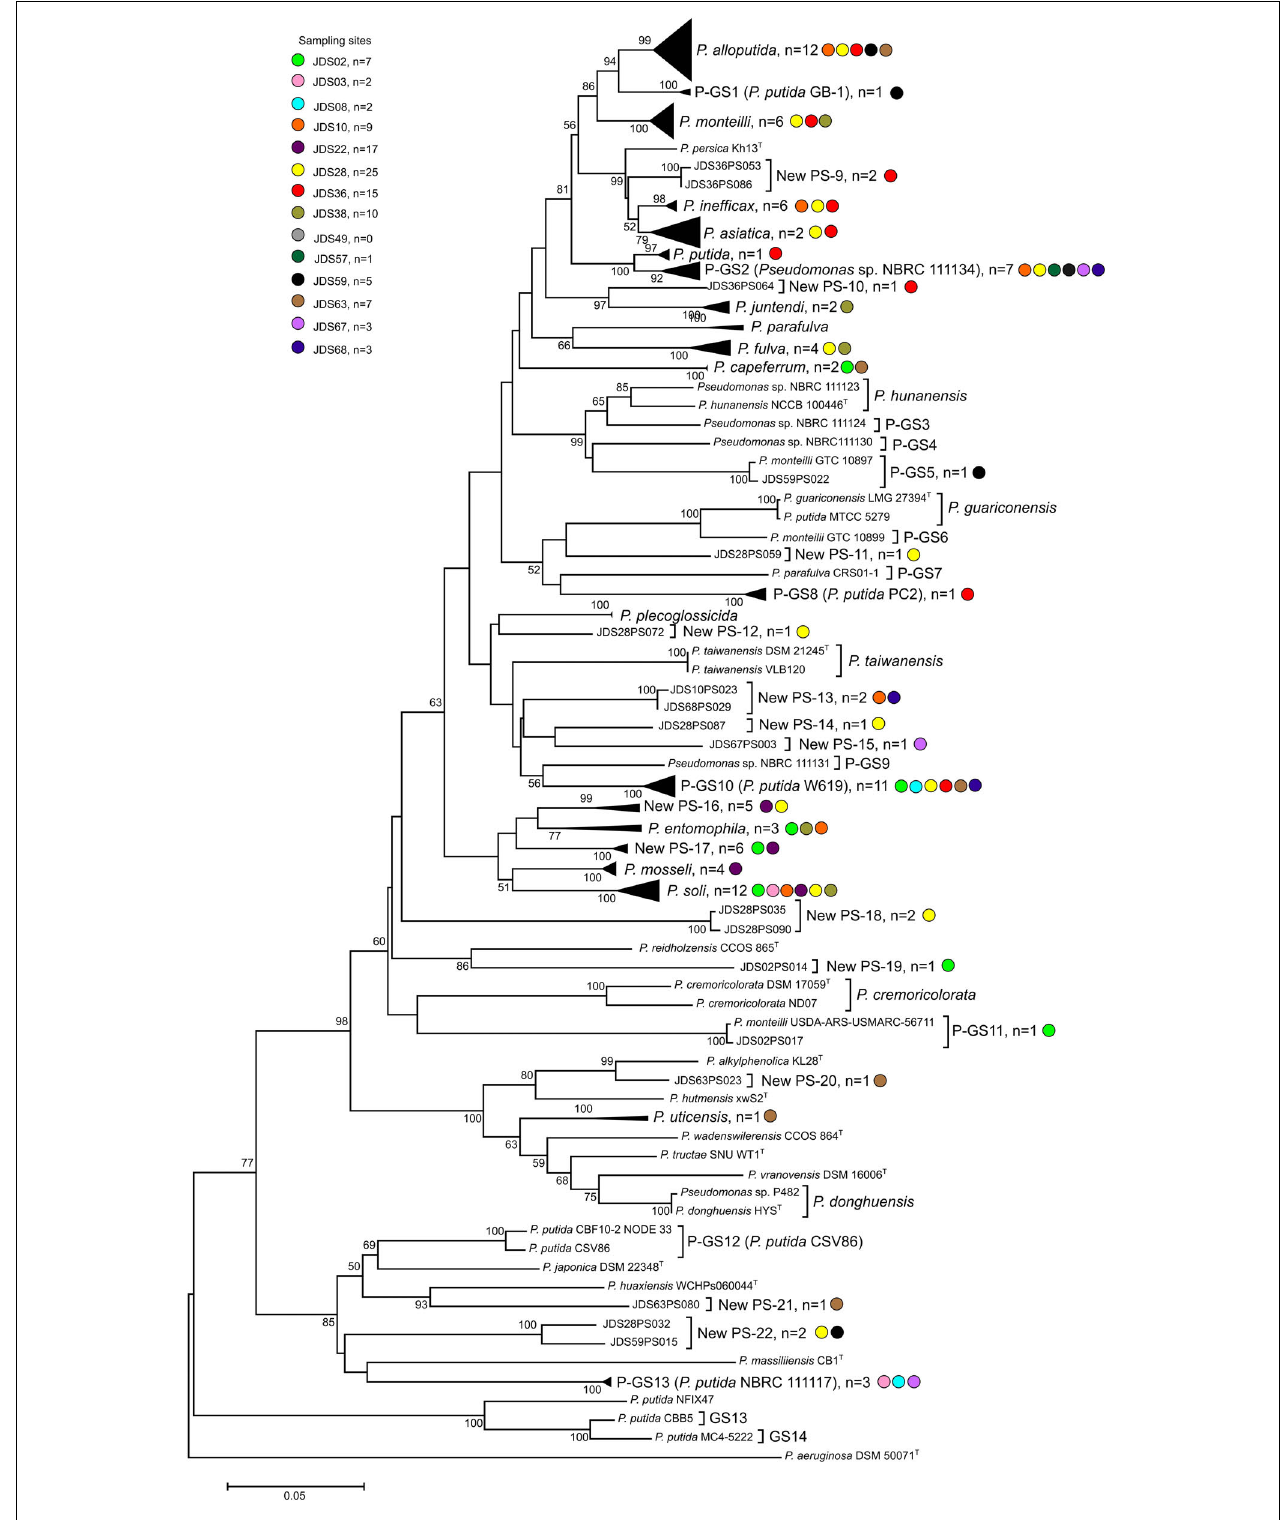
FIGURE 3 | Phylogenetic tree of the strains in the P. putida phylogenetic group based on the partial rpoD gene sequence analysis. Colored dots indicate the sampling site and “n” the number of strains. Distance matrices were calculated by the Jukes-Cantor evolutionary model. Dendrograms were generated by the neighbor-joining method. P. aeruginosa ATCC 10145 T was used as the outgroup. The bar indicates sequence divergence. Percentage bootstrap values of more than 50% (from 1000 replicates) are indicated at the nodes.